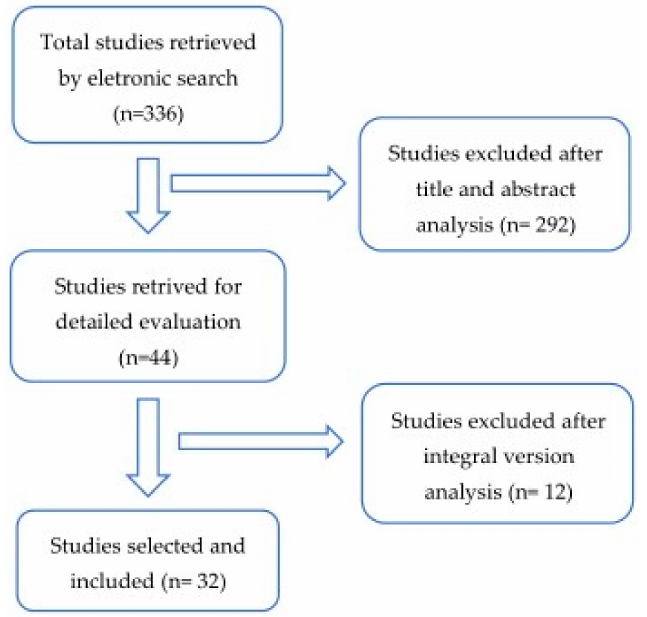
Figure 2. Flow diagram of the articles selection process through a systematic